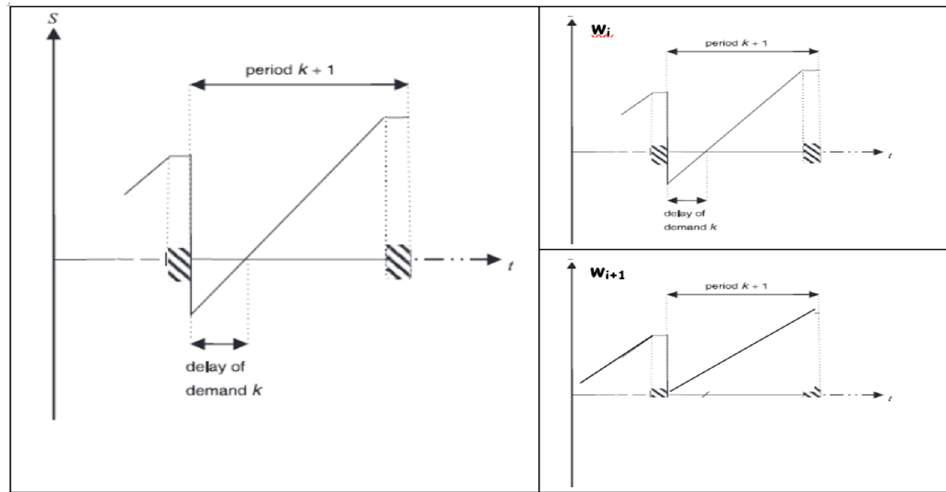
Figure 4. S hortage of inventory level. Figure 4. Shortage of inventory